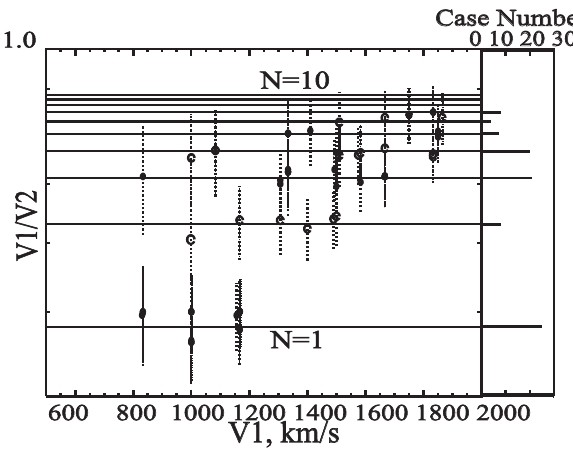
Fig. 46. Statistical verification of the scaling law for resonance structures predicted by Ashour-Abdalla et al. (1993). V 1 /V 2 (empty and black circles) is plotted against V 1 . The resonance level, [ N ] 2 / 3 , for N =1,..,10 are shown by horizontal lines. The solid N + 2 bars shown in the right part of the figure indicate the number of measurements of double-peaked distributions corresponding to the each particular resonance level. (From Zelenyi et al.,